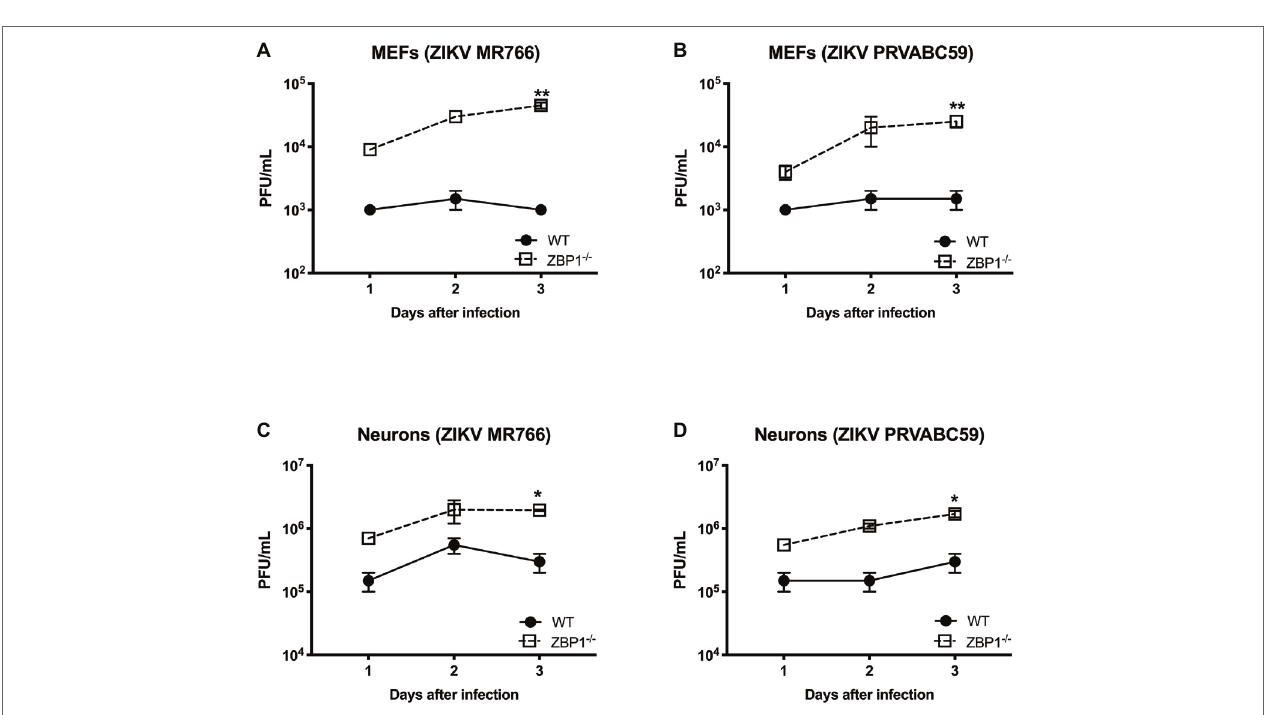
FIGURE 7 | Analysis of ZIKV yields produced by primary mouse cells. (A–D) MEFs and neuronal cultures derived from WT and ZBP1 −/− were infected with ZIKV MR766 or ZIKV PRVABC59 at a MOI of 1 and virus titers in the cell culture supernatants were measured by plaque assay. Results are expressed as PFU/mL ± SEM from at least three independent experiments conducted in duplicate. * p < 0.05, ** p <